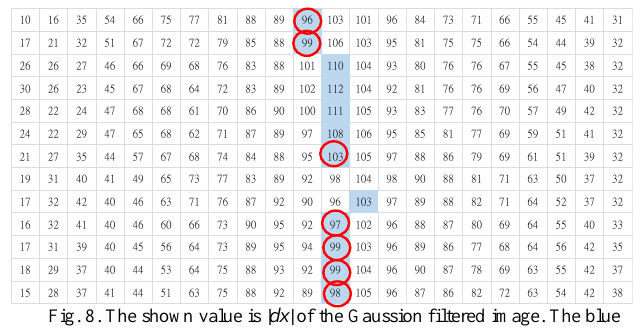
Fig. 8. The shown value is | dx | of the Gaussion filtered image. The blue blocks are the edge points obtained by Canny edge detection and the blocks with a red circle will be eliminated with the two constraints.